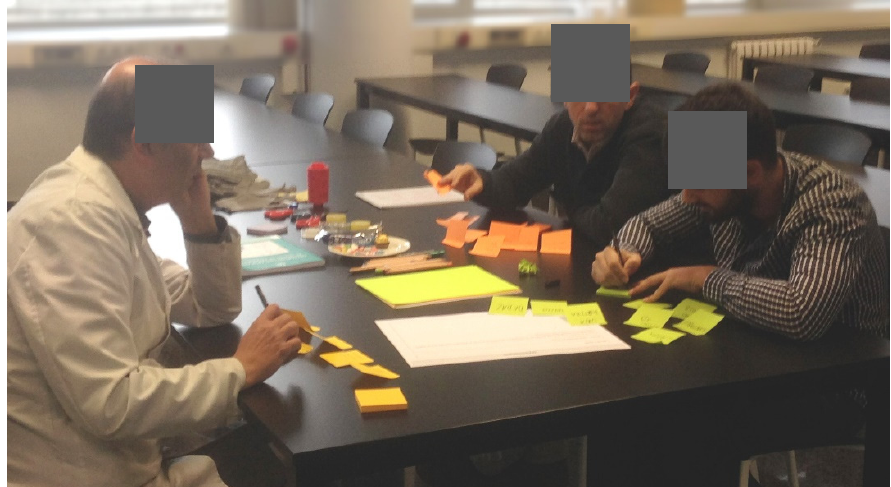
Figure 12. Internal workshop participants during the Brainstorming.